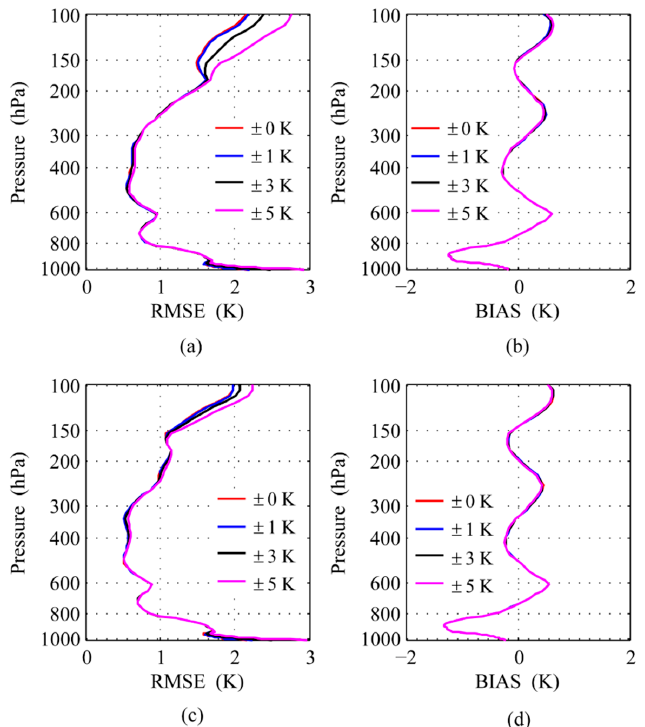
Figure 9. The temperature retrieval results of FY-4A and FY-4B with different temperature perturbations: ( a ) RMSE of FY-4A; ( b ) BIAS of FY-4A; ( c ) RMSE of FY-4B; ( d ) BIAS of FY-4B.